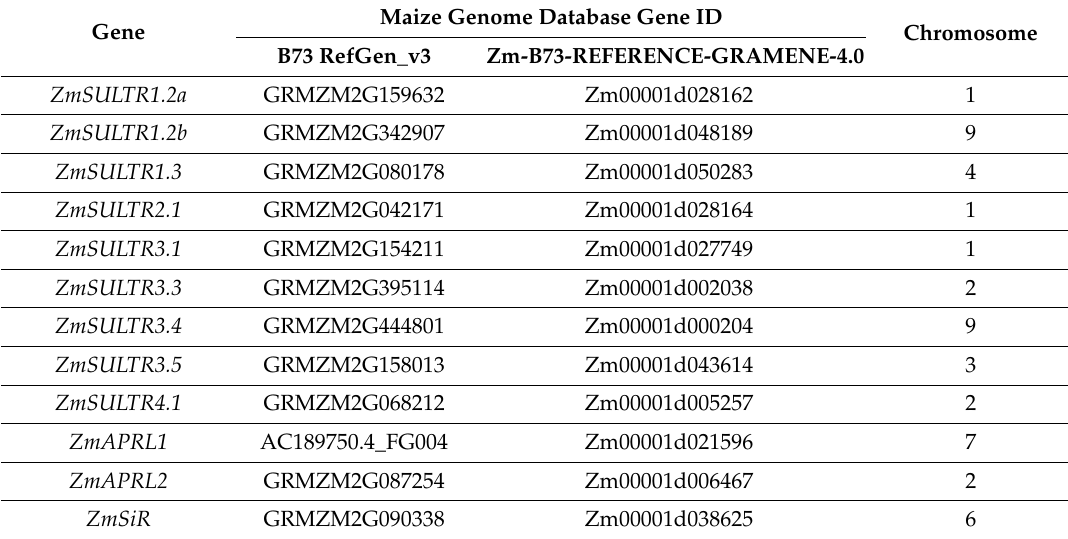
Table 1. Putative sulfate transporters, adenosine 5’-phosphosulfate reductases (APRs) and sulfite reductase (SiR) of Zea mays